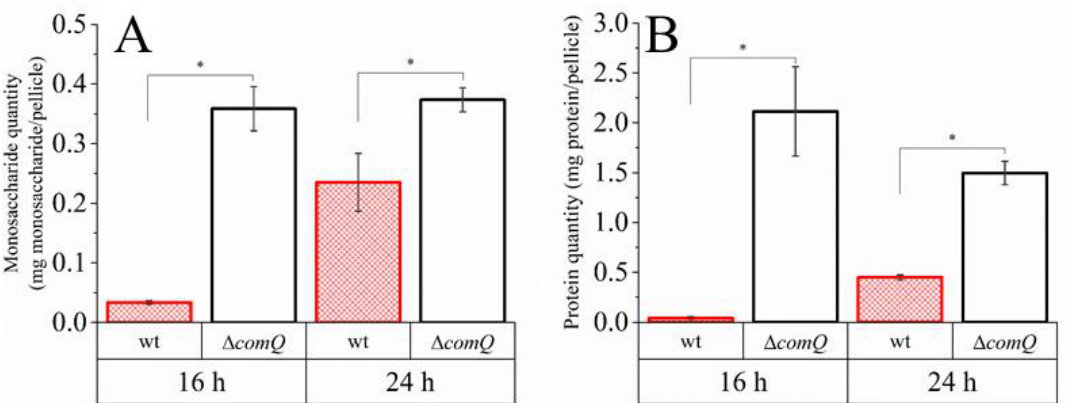
Figure 6. Monosaccharide and protein quantity in B. subtilis PS-216 (wt; PS-216) and QS mutant phenotype (ΔcomQ; BM1127) pellicles during static growth in the MSgg medium at 37 °C. ( A ) Monosaccharide content was determined with the phenol – sulfuric acid method. ( B ) Protein content was determined with the Bradford protein assay. Averages with the standard error of means (SEM) of three biological replicates are shown. Statistical significance (marked with *) was determined using a one-way Mann –Whitney test and a Student’s t -test ( p < 0.05).